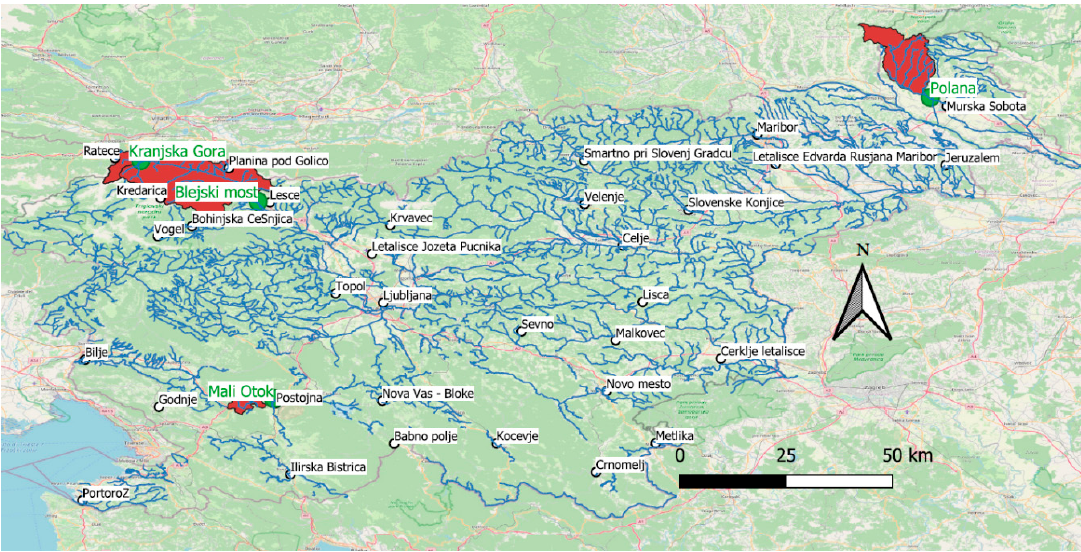
Figure 1. Location of the considered meteorological and climatological stations (white dots) and location of four selected catchments (red areas, green dots show water level gauging stations) with a river network in Slovenia (blue lines).